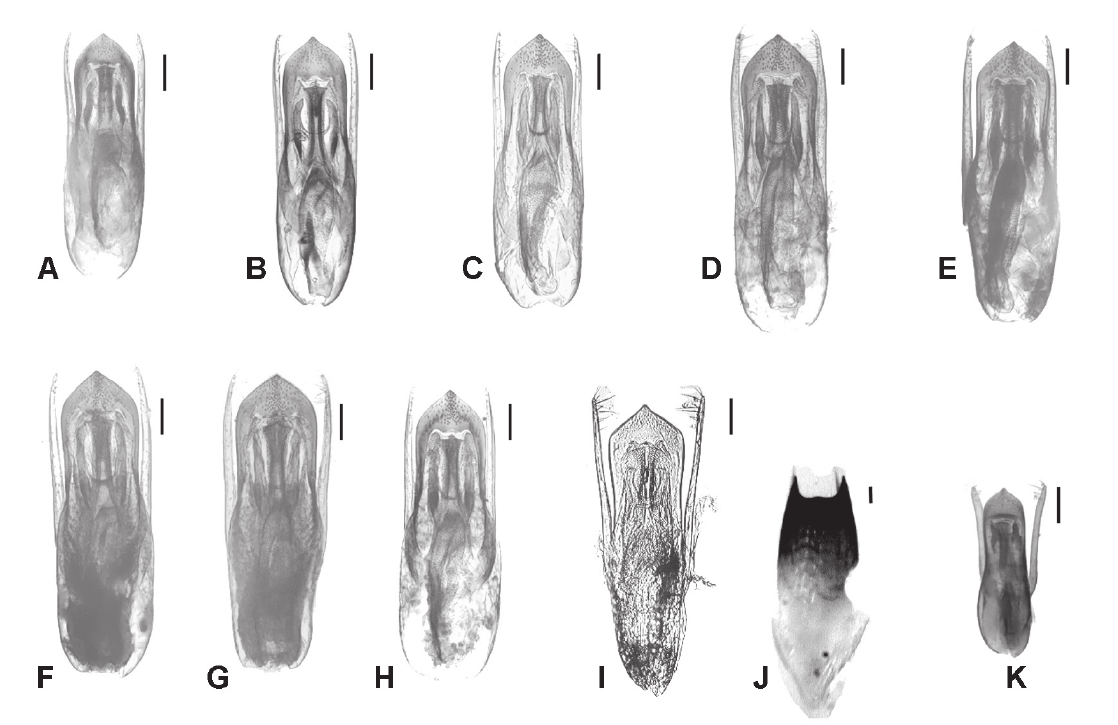
Fig. 7. ♂ copulative structures. A – I , K : Aedeagus, ventral view. J : Abdominal sternite 9. A . Stenus ( Nestus ) delitor sp. nov. (holotype). B . S. ( N. ) illusor Ryvkin, 1987 (Russia: Amur Area: